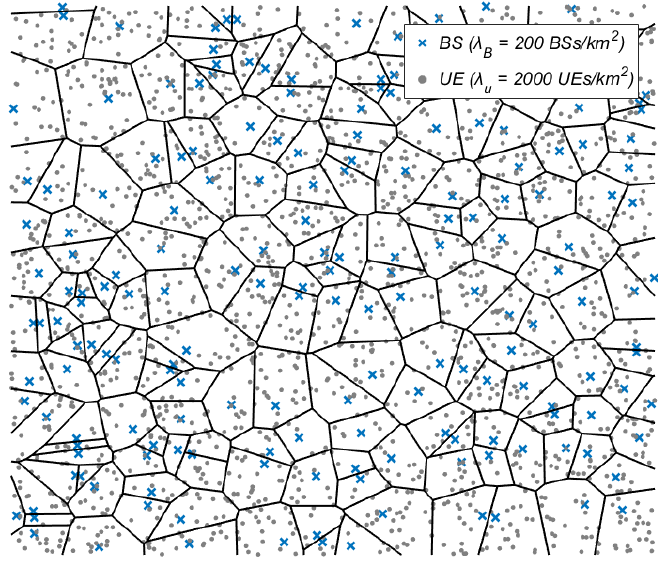
Figure 1. An example of network configuration based on stochastic